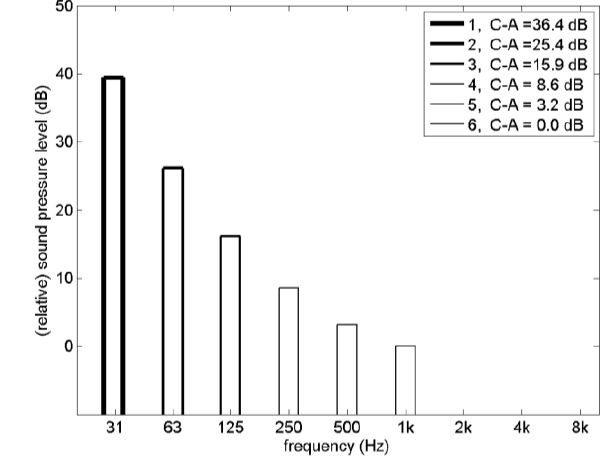
Figure 4. Six spectra with sound energy confined to a single 1/3-octave band. Values of the difference between the C-weighted sound level and the A-weighted sound level, denoted as C–A, are indicated in the legend.